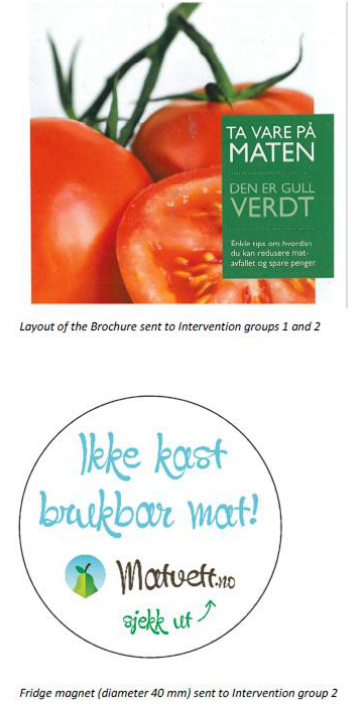
Figure A1. Material used in the Household Intervention.